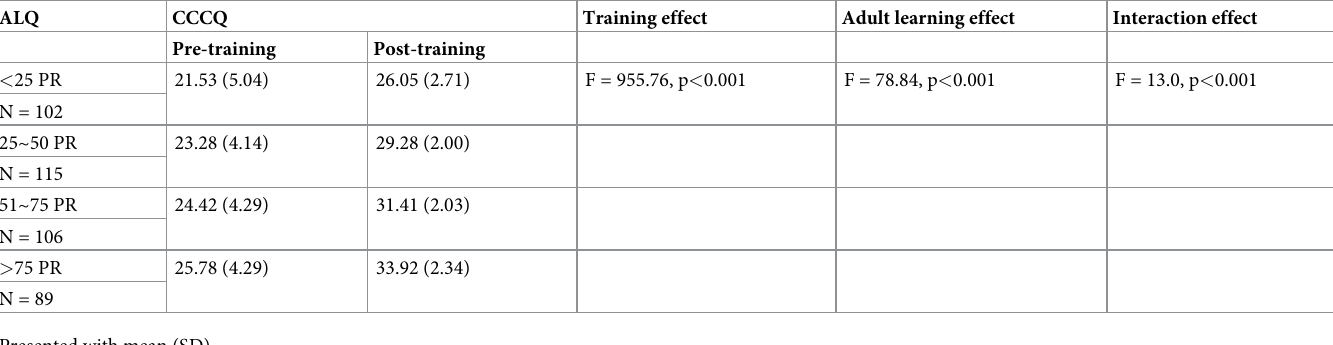
Table 1. Pre- and post-perioperative training surgical competencies by quartile of adult learning among medical students. ALQ